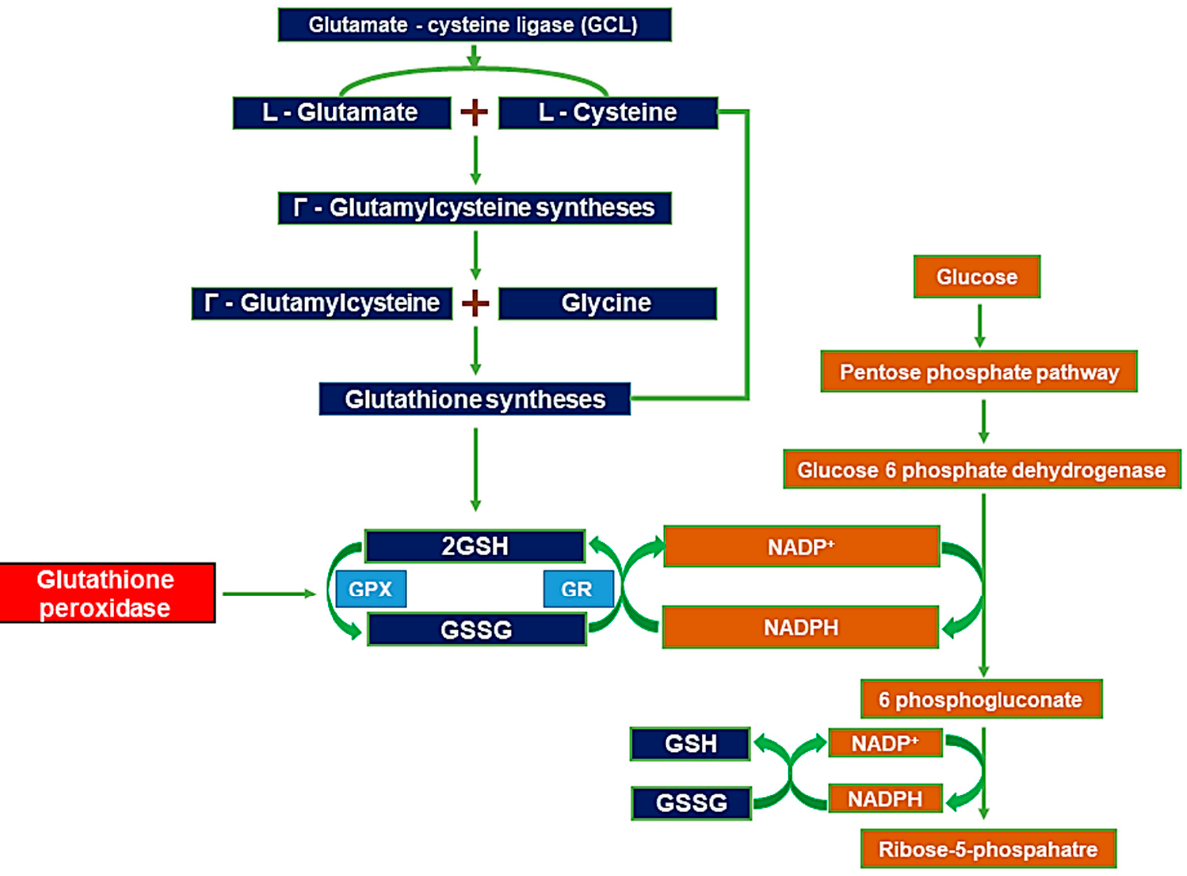
Figure 1. L-glutamate and L-cysteine are bound by glutamate–cysteine ligase enzyme. γ -glutamyl cysteine and glycine combine to form glutathione synthase [31,38–40]. GSH and GSSG conversion is mediated by hydroxy peroxide and GSH reductase [41–43]. Pentose phosphate pathway (PPP)- derived NADPH supplies electrons to GSSG via GSH reductase [44,45].